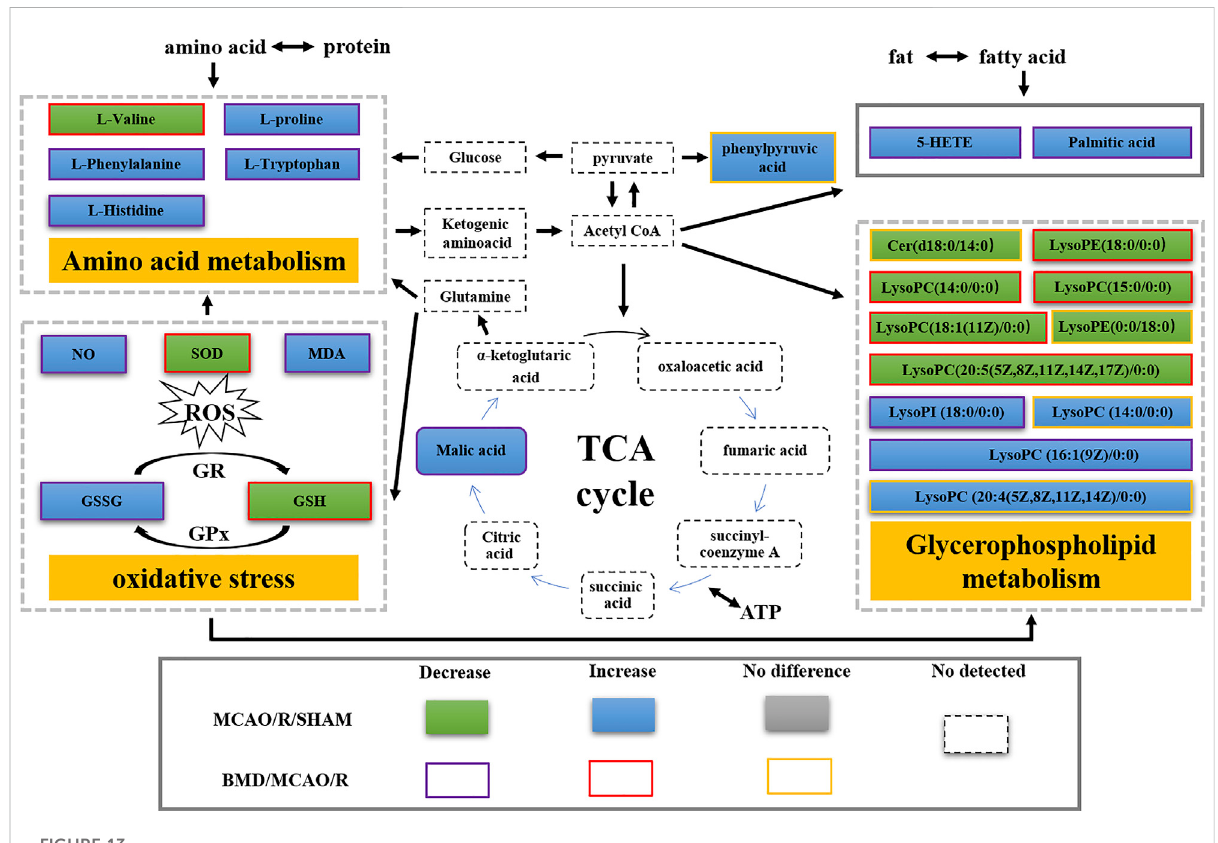
FIGURE 13 Metabolic disorder map of the MCAO/R model